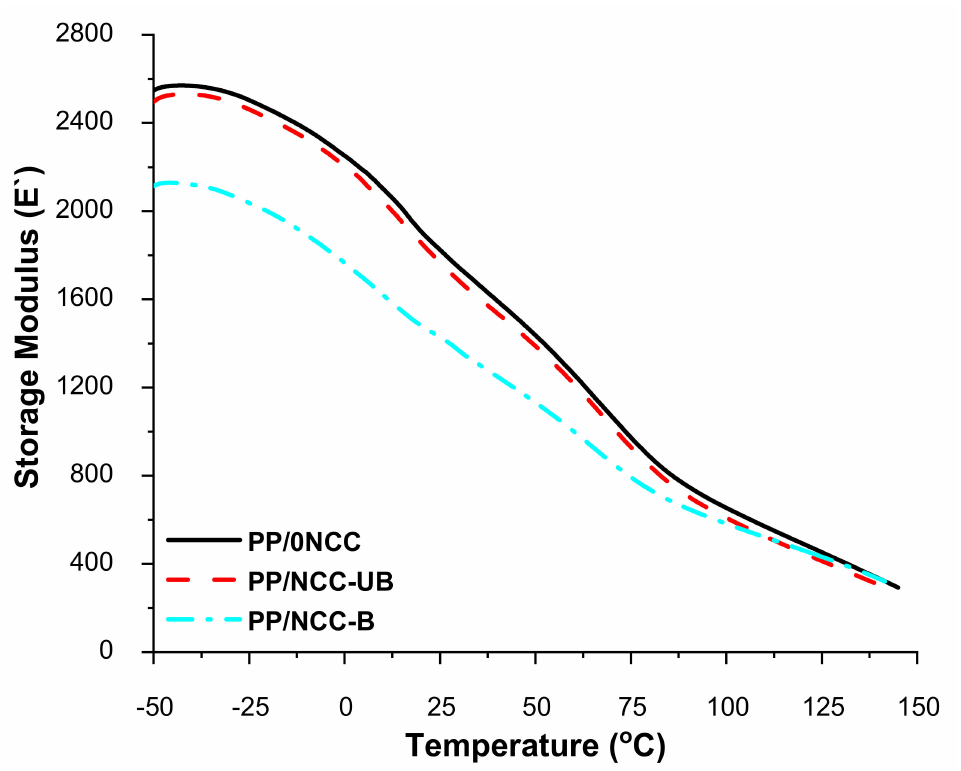
Figure 5. The storage modulus of kenaf core nanocomposites reinforced bleached and unbleached